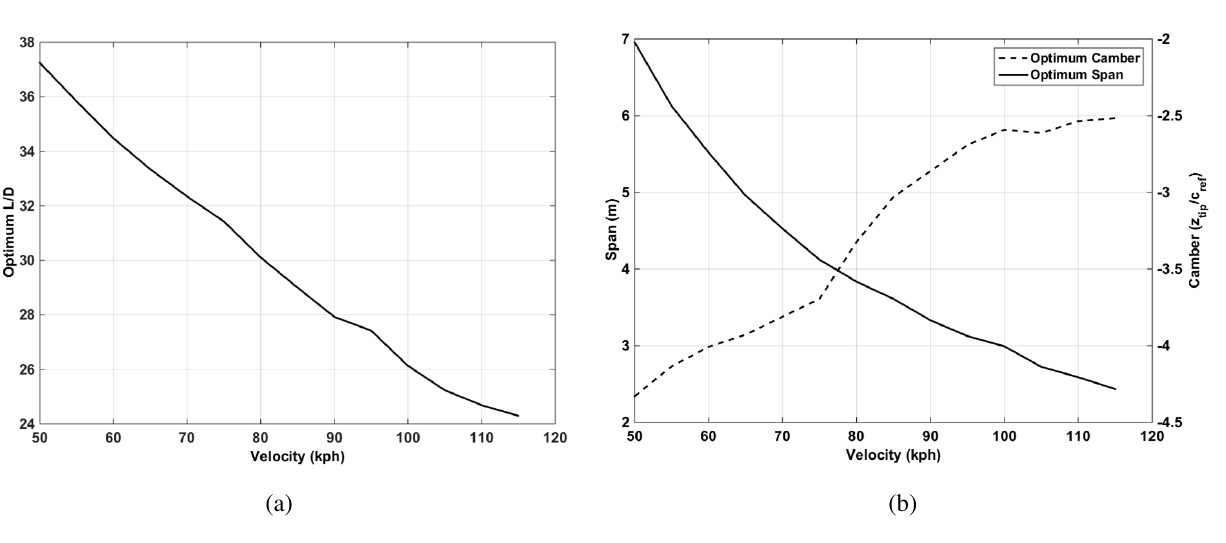
Figure 9. Optimum parameters for the speed range from 50–115 kph. ( a ) Optimum aerodynamic efficiency; ( b ) optimum span and